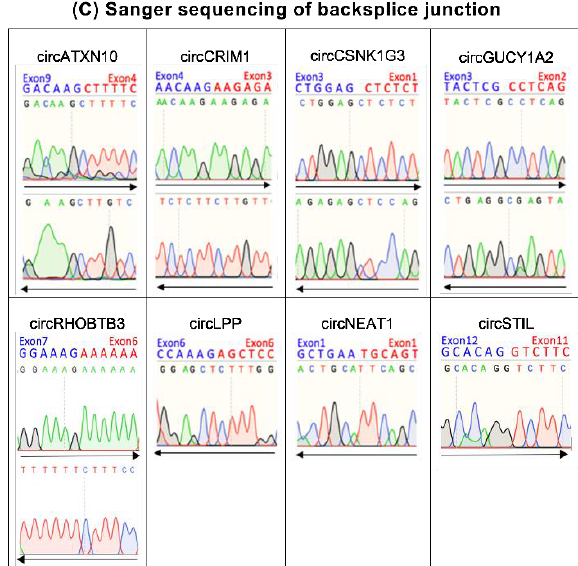
Figure 3. Experimental proof of the circular nature of the circRNAs selected in this study. ( A ) Resistance of circRNAs to RNase R digestion compared with linear RNAs. Data for triplicates (mean ± standard deviation) normalized to controls without RNase treatment are presented. ( B ) Decreased cDNA synthesis of circRNAs with oligo(dT) 18 vs. random hexamer primers. Data are given as the relative expression normalized to hexamer-primers-based cDNA synthesis. The relative expression was markedly decreased in all circRNAs (at least n = 3 of tissue pools) when using oligo(dT) 18 primers in comparison to random hexamer primers, indicating that the circRNAs lacked a poly(A) tail. ( C ) Base sequence of circRNA backsplice junction pictured by Sanger sequencing. Circ LPP , circ NEAT1 , and circ STIL were only sequenced in one direction as one of the primers was junction-spanning (Table S3). The sequencing result of circ RHOBTB3 corresponded to that in kidney carcinoma [22]. Methodical details for all experiments listed here are described in Section 4 and Supplementary Information S4 (Supplementary Materials).